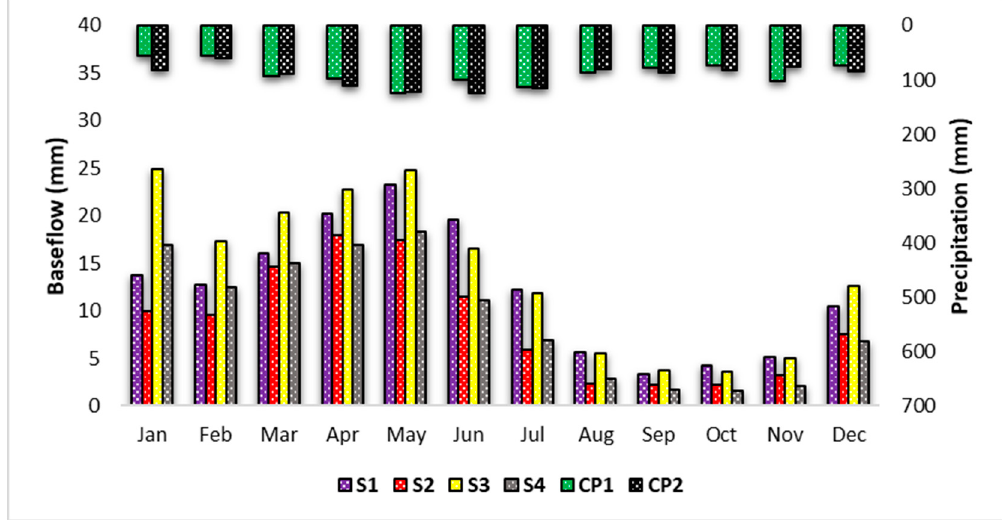
Figure 9. Average monthly baseflow for the LEC watershed under different scenarios.